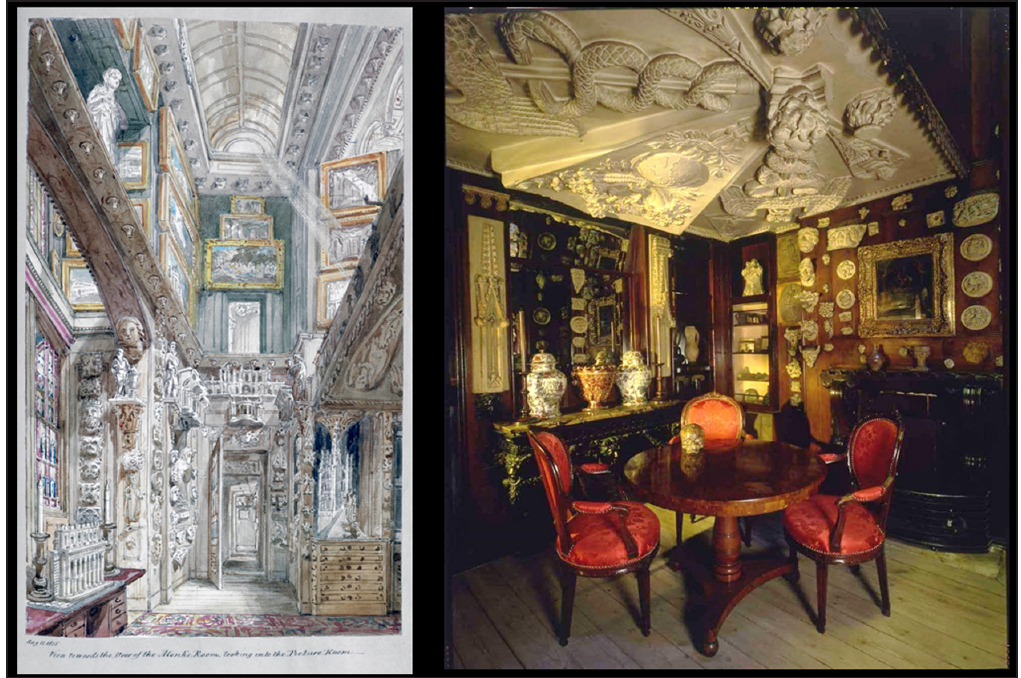
Fig. 8 : Joseph Michael Gandy, View of the Monk’s Parlour, 1825, watercolour, Sir John Soane’s Museum SM Vol. 82/67 (left); and photograph of the parlour looking in the opposite direction (right). © Sir John Soane’s Museum. Photo: Martin